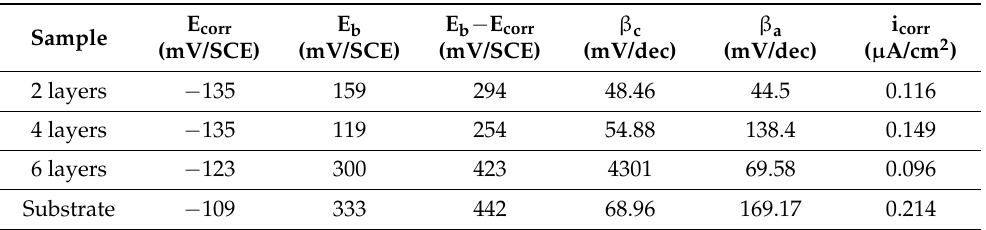
Table 4. Electrochemical parameters of the potentiodynamic polarization curves for substrate and deposited layers samples.